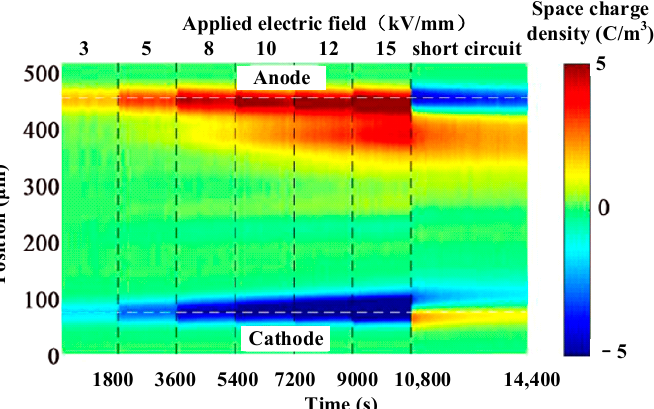
Figure 12. Space charge measurement results of silicone encapsulation material at 80 °C (dotted line: different stage of experiment) [87].